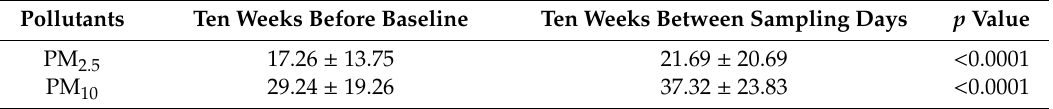
Table 1. Particulate matter levels ten weeks before and after the